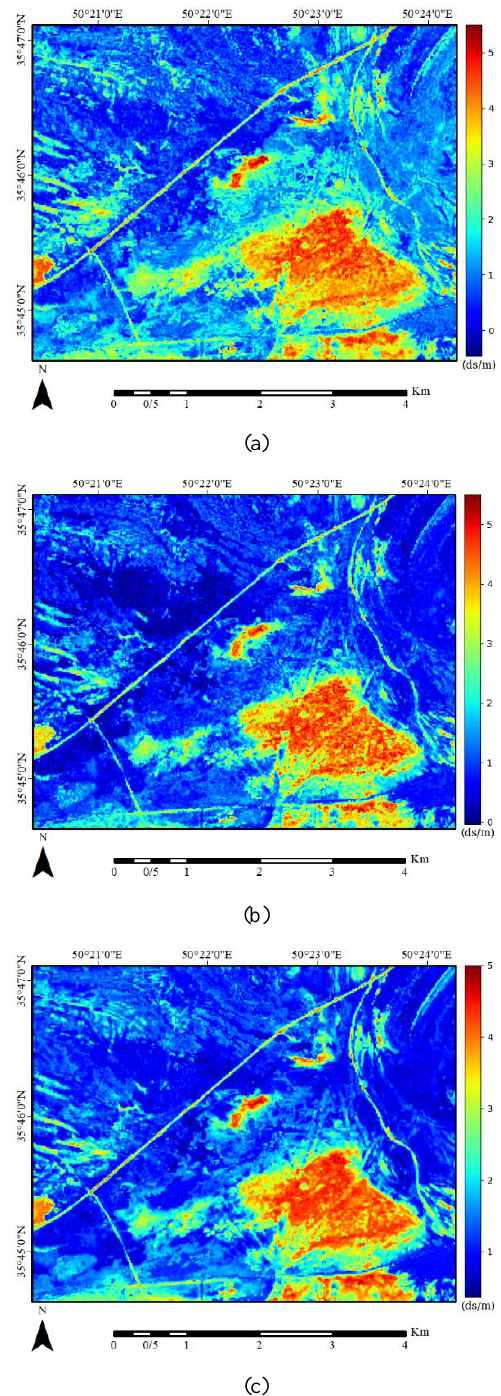
Figure 5. Predicted soil EC maps based on the results of regression analysis, (a) Gradient Boost Machine, (b) XGBoost, and (c) Random